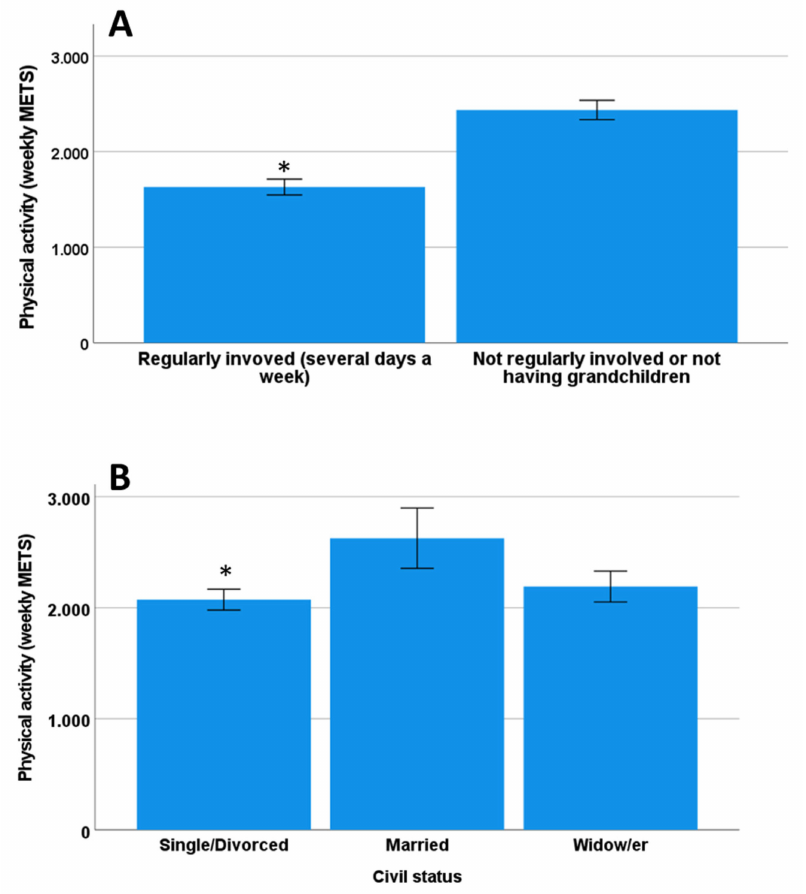
Figure 2. Physical activity (weekly METS) in participants involved or not in the care and parenting tasks ( A ) in participants according to their civil status ( B ). * p <